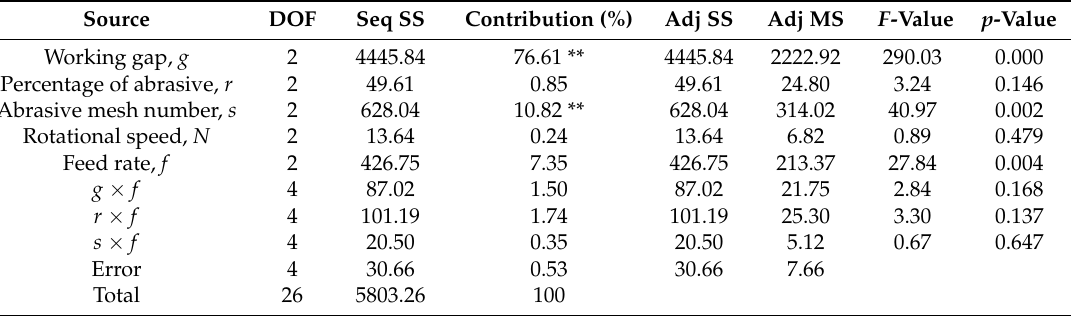
Table 6. Results of pooled ANOVA of ∆ R a for Al 2 O 3